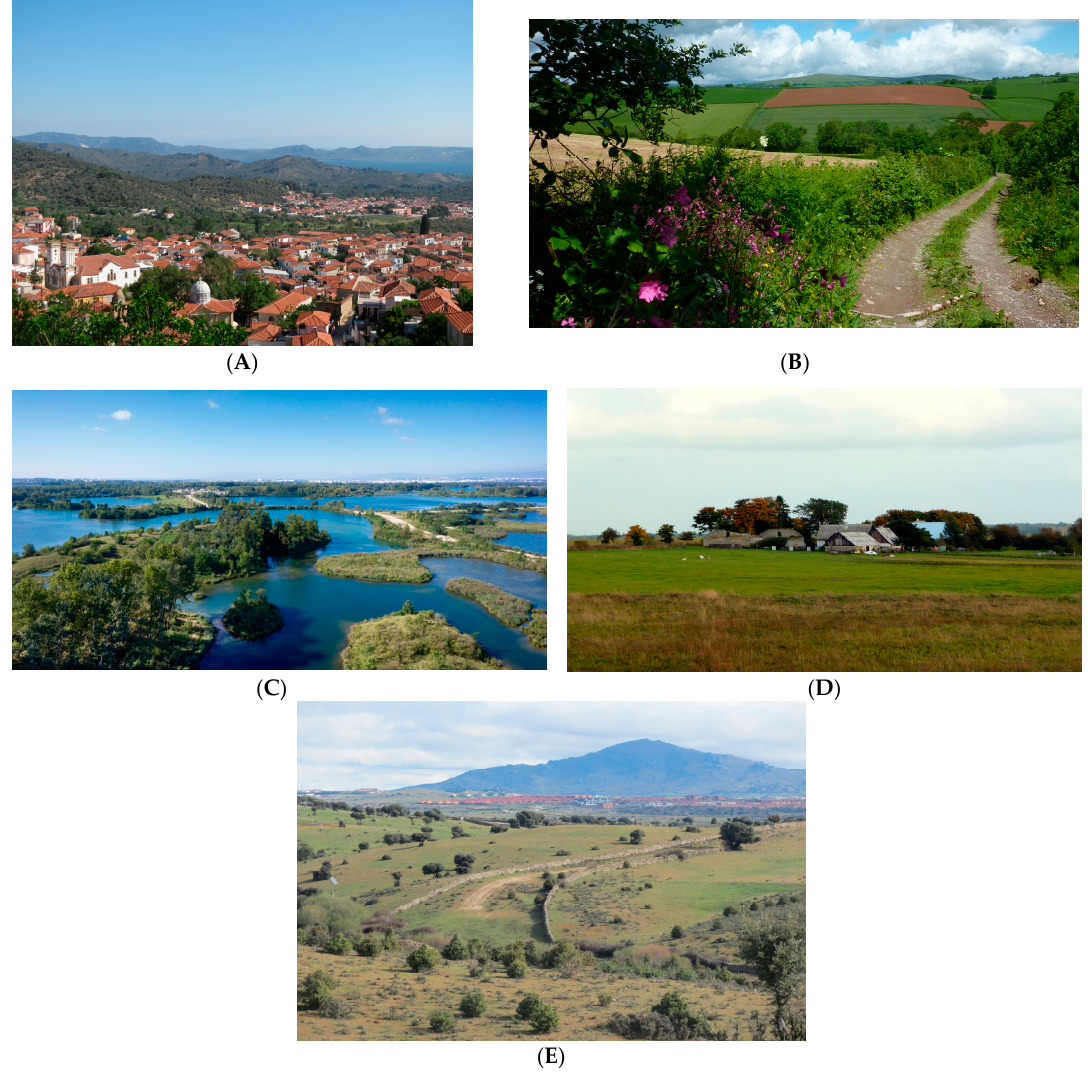
Figure 1. Typical landscapes in the case study areas. ( A ) Gera and Plomari; ( B ) Modbury; ( C ) Grand Parc Miribel Jonage; ( D ) Alatskivi and Peipsiääre, Vooremaa and Kodavere; ( E ) Colmenar Viejo. Table 1. The case study areas and their landscapes.